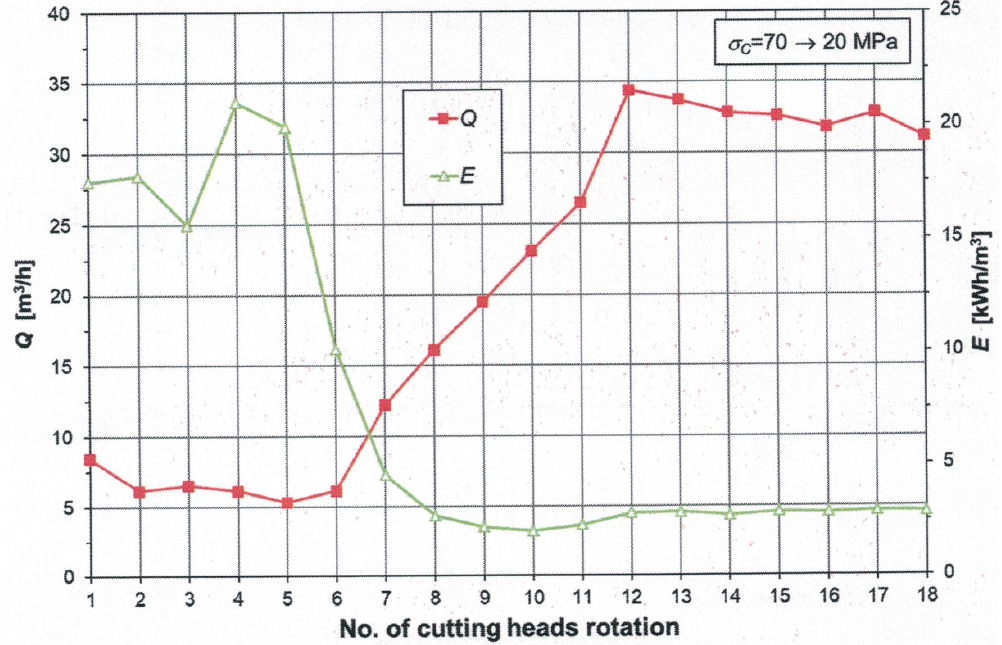
Figure 12. Mining efficiency ( Q ) and energy consumption ( E ) in subsequent rotations of the cutting heads during the performance of lower cut in the automatic control mode in rocks with decreasing uniaxial compressive strength.